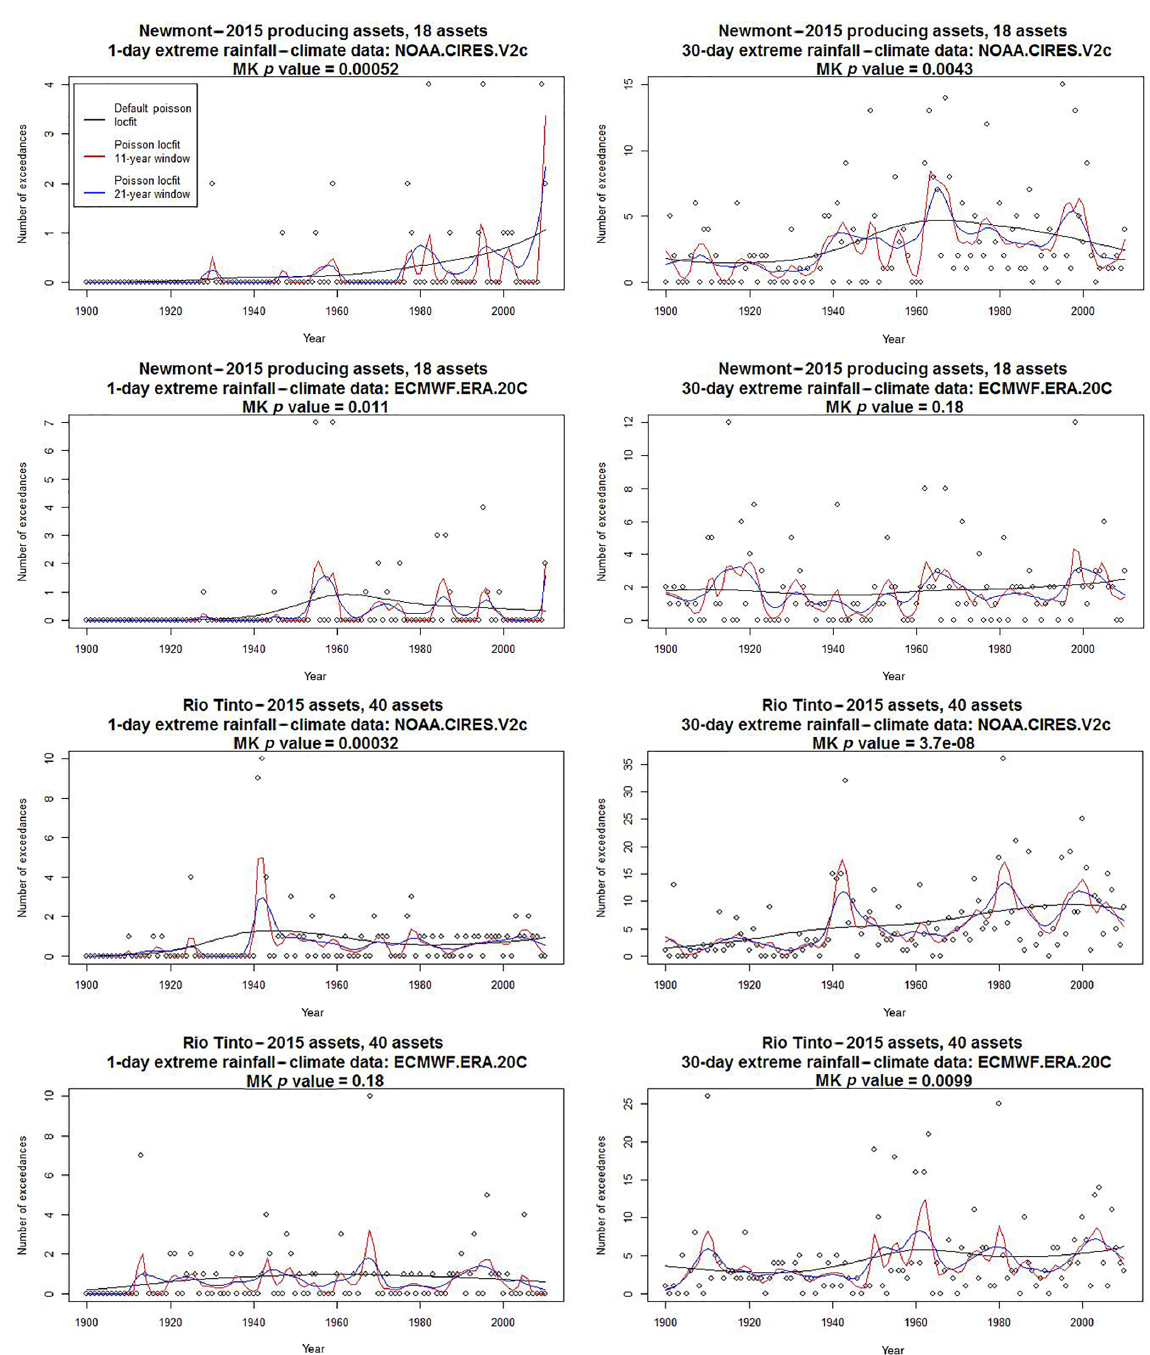
Figure B1. Time series N t (p) of the yearly number of 1-day (left panels) and 30-day (right panels) extreme rainfall events hitting the four mine portfolios computed from two climate datasets: 20CR and